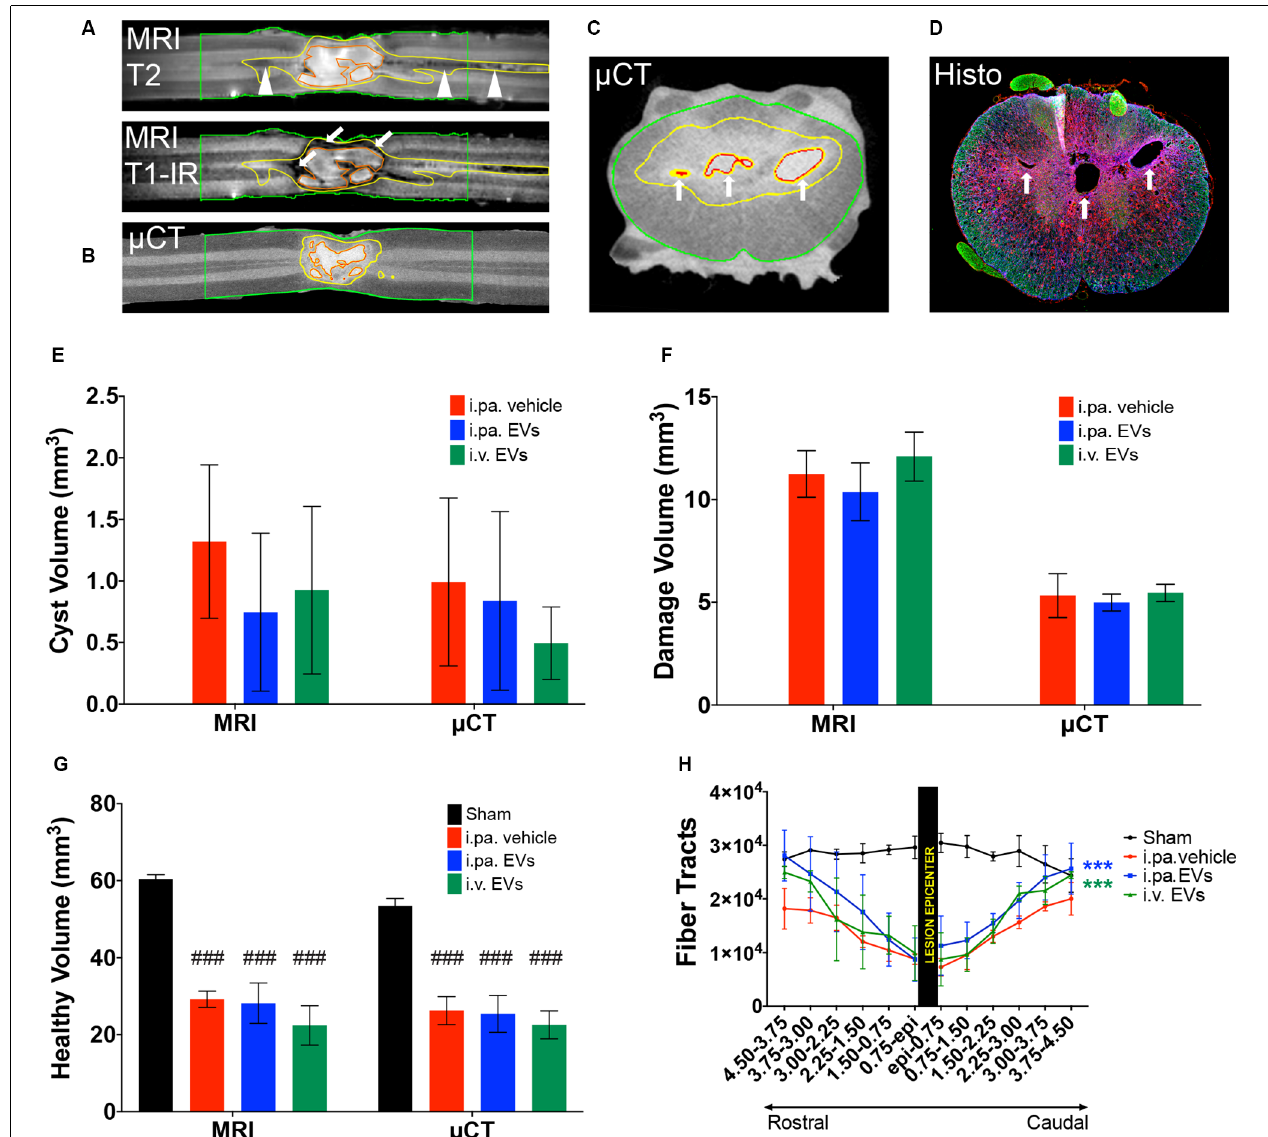
FIGURE 5 | Acute application of EVs improved structural outcomes after tSCI. Representative magnetic resonance (MRI) and micro-computed tomography ( µ CT) images of vehicle-treated rats at 56 days post-tSCI. Corresponding horizontal sections obtained with (A) T1-IR and T2 MRI sequences or (B) contrast agent-enhanced µ CT. Arrows point to dense scar tissue in (A) , arrowheads point to degenerating tracks in (A) . Corresponding cross-sections obtained with (C) contrast agent-enhanced µ CT and (D) immunohistology (GFAP in blue, NF-H in green and Iba1 in red). Arrows point to cysts in (C) and (D) . (A) to (C) : red lines: cysts; yellow lines: damaged tissue and green lines: sample borders. Quantification of the (E) volume of cysts, (F) volume of damaged tissue including cysts, and (G) volume of intact-appearing tissue. (E–G) Statistical differences to sham group using one-way ANOVA and Tukey post hoc test on all groups: ( ### ) p < 0.001. (H) Longitudinal fiber tracts rostral and caudal to the lesion epicenter detected by DTI. Statistical differences to vehicle group using two-way ANOVA and Tukey post hoc test on tSCI groups (without sham): ( ∗∗∗ ) p <